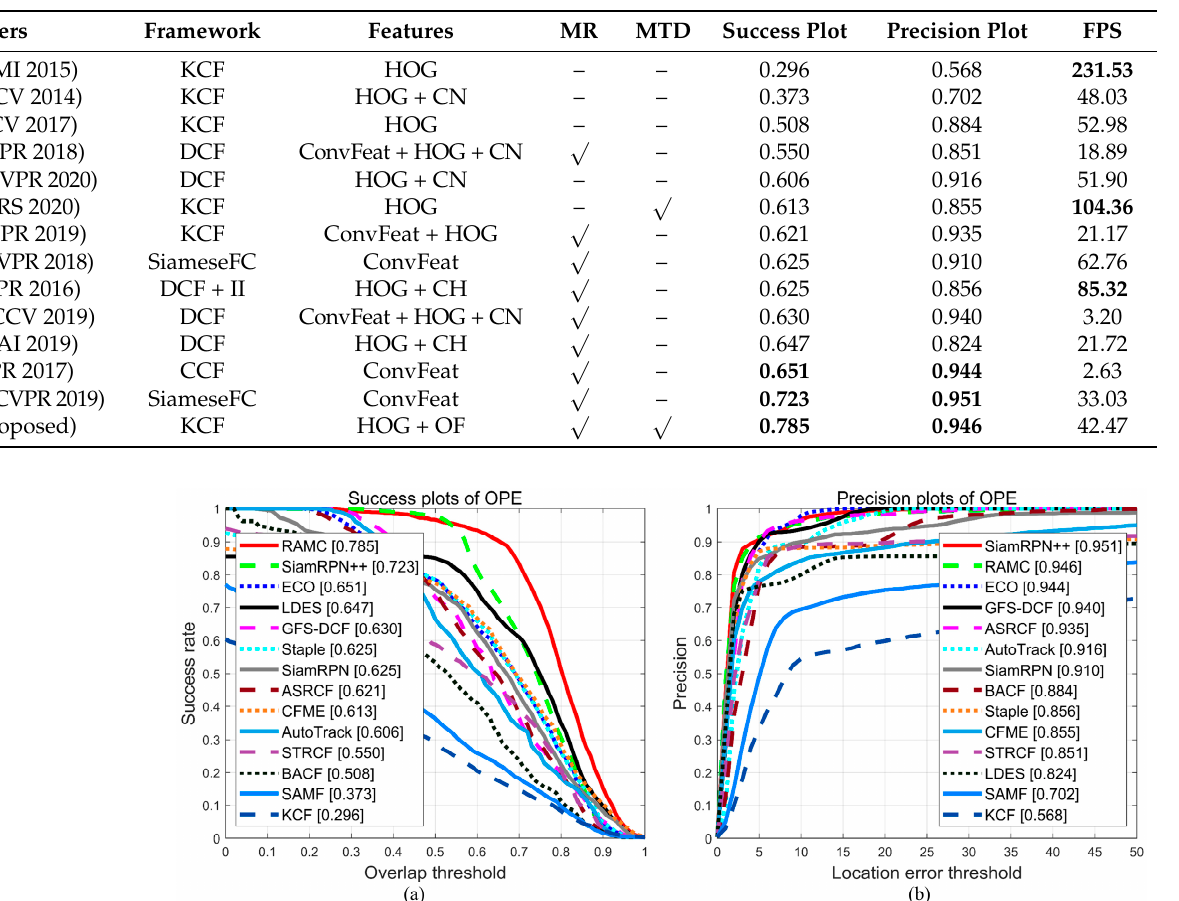
Table 4. Details of trackers and experimental results on datasets. The top three of each met- ric is bolded. “MR” = Mechanisms for Rotation. “MTD” = Mechanisms for Tracking Drift. For trackers, “TGRS” = IEEE TRANSACTIONS ON GEOSCIENCE AND REMOTE SENSING. For framework, “KCF” = Kernelized Correlation Filter, “DCF” = Discriminative Correlation Filter, “SiameseFC” = Fully Convolutional Siamese Network, “II” = Integral Image and “CCF” = Continuous Convolution Filter. For features, “HOG” = HOG, “CN” = Color Names, “ConvFeat” = Convolutional Features, “CH” = Color Histogram and “OF” = Optical Flow.